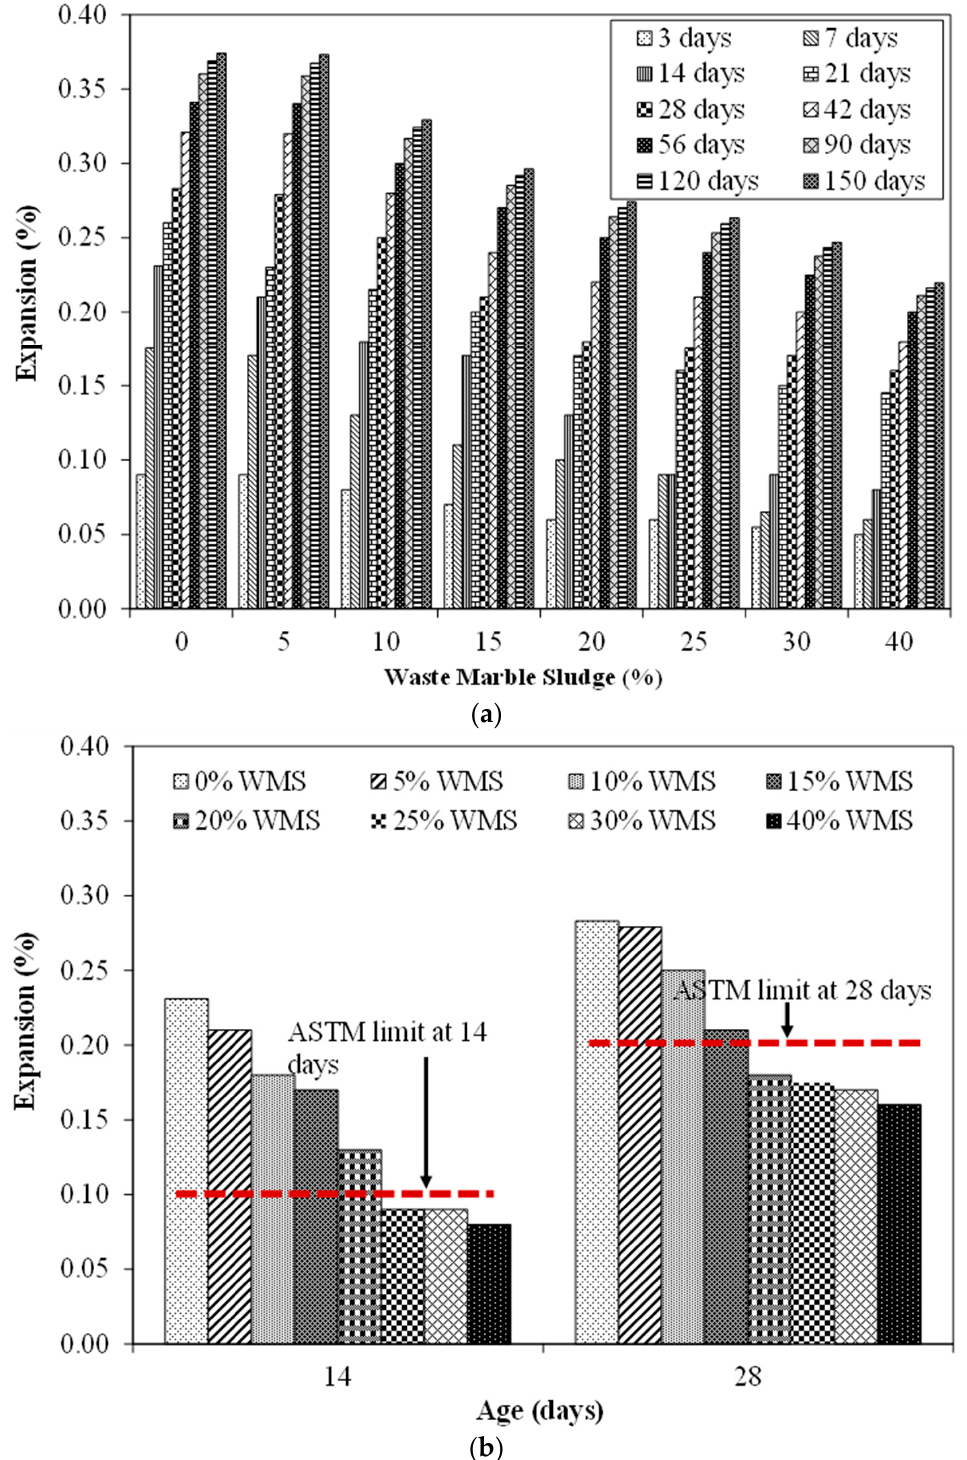
Figure 6. Expansion results ( a ) at all ages ( b ) at 14 days and 28 days with ASTM limits.